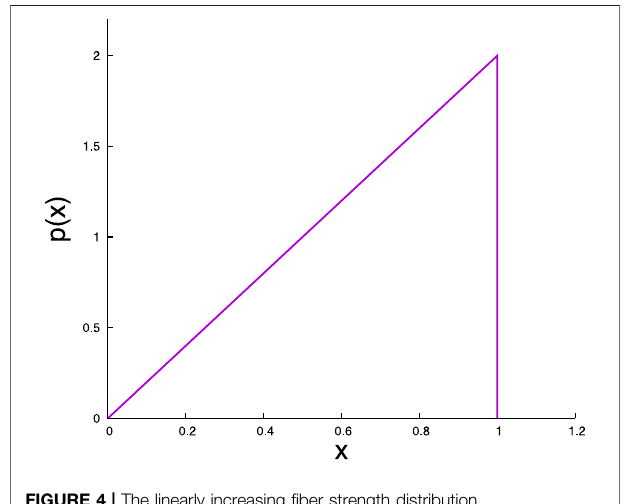
FIGURE 4 | The linearly increasing fi ber strength